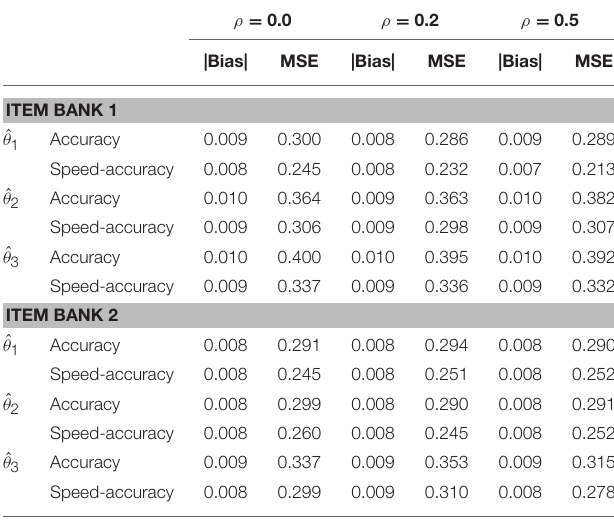
TABLE 3 | Comparing IRT-based ERS algorithms for correctness vs. trade-off score (correctness and speediness combined). ρ = 0.0 ρ = 0.2 ρ =